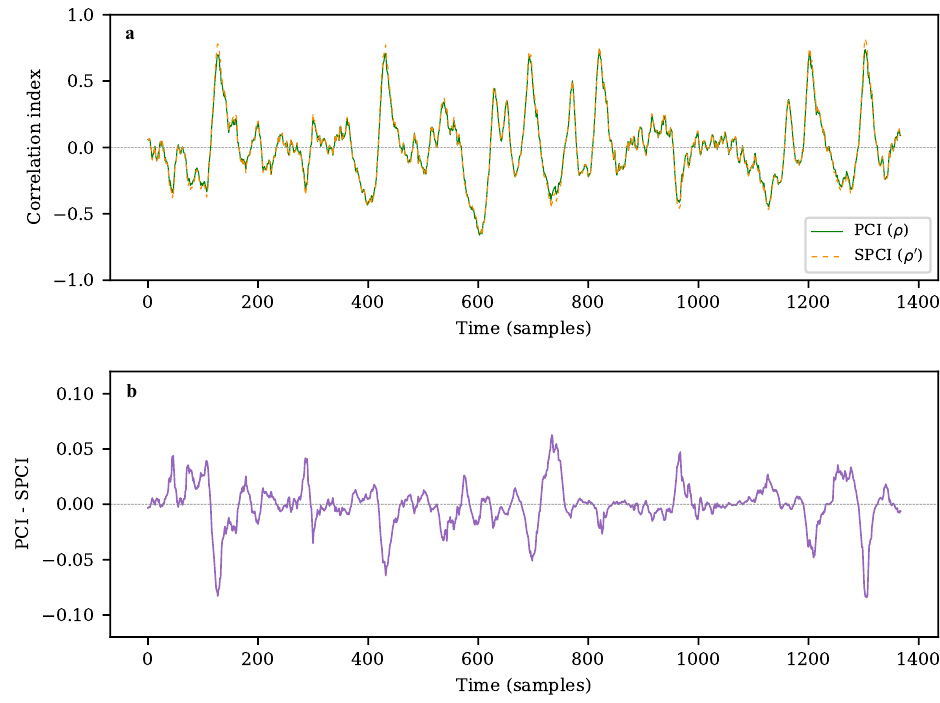
Figure 10. ( a ) Pearson ( ρ ) and simplified ( ρ (cid:48) ) correlation results of stimulus ( x ) with PSNR = 3 over a sliding window, based on a double exponential pattern ( c ) of size N = 64. ( b ) Difference between correlation indices ρ and ρ (cid:48)